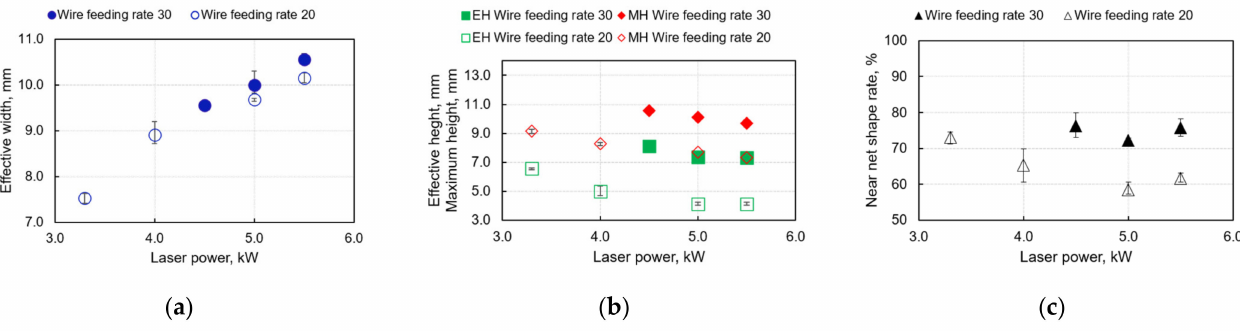
Figure 18. Cross-sectional characteristics ( V p = 0.3 m/min): ( a ) effective width, ( b ) effective height and maximum height, and ( c ) near net shape rate.